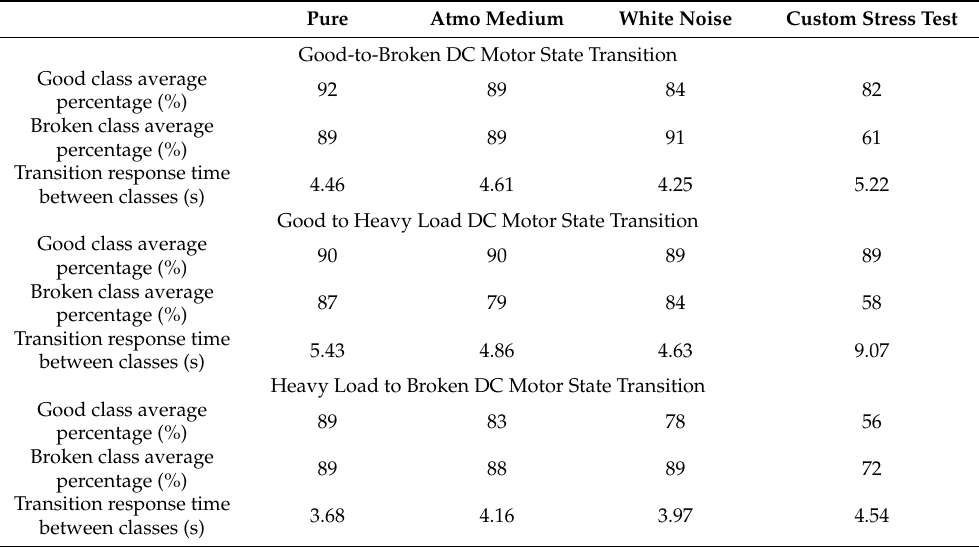
Table 7. Average percentage indications for each class and environmental background, along with transition response times between classes for the STM’s methodology model.